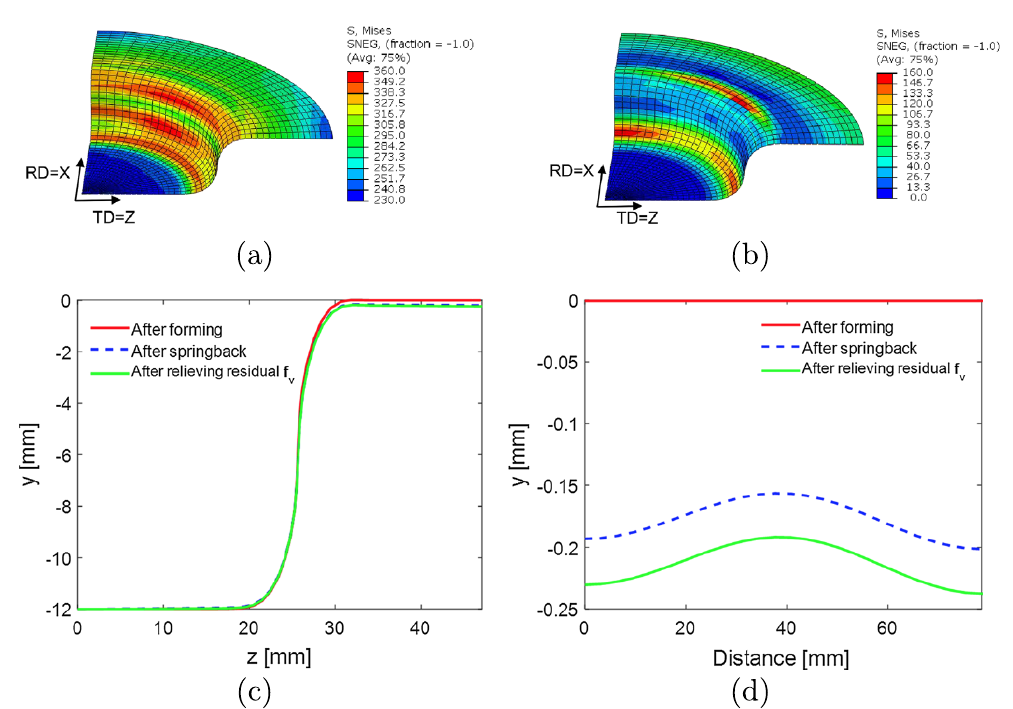
Figure 8. Cup drawing and springback simulation of AA6022-T4 sheet: ( a ) von Mises stress contours at the end of forming; ( b ) von Mises stress contours after springback relaxation; ( c ) shape change after springback of y-z profile; ( d ) shape change after springback of the circumference of the down cup flange. Reproduced from [178], under